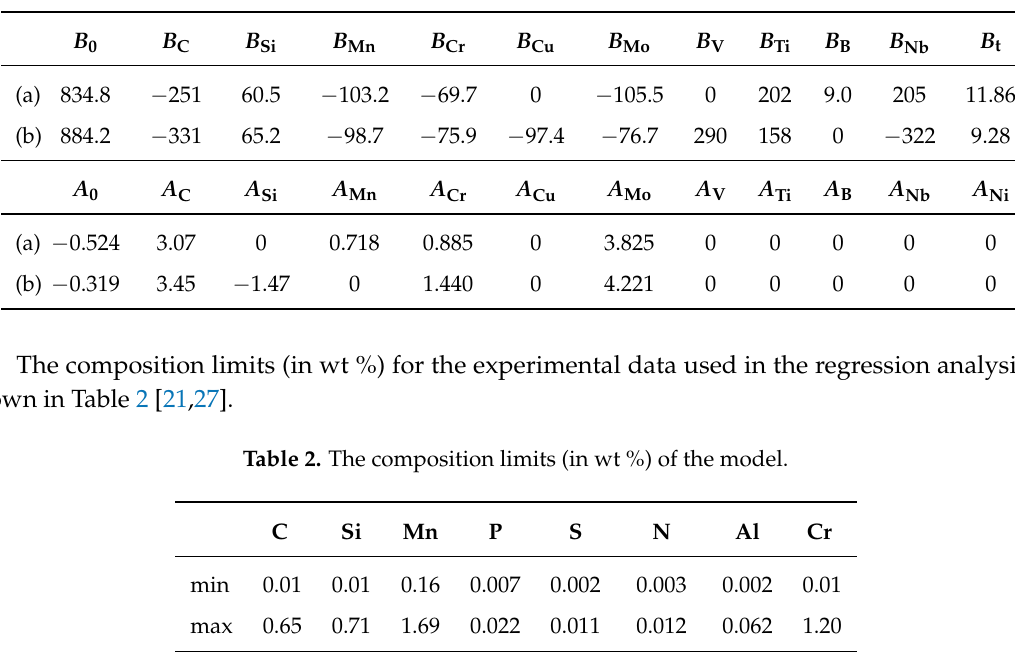
Table 1. The regression constants given in [21], which were used in Equations (1) and (2). The constants are given for two different deformation schedules, (a) and (b) (see text).